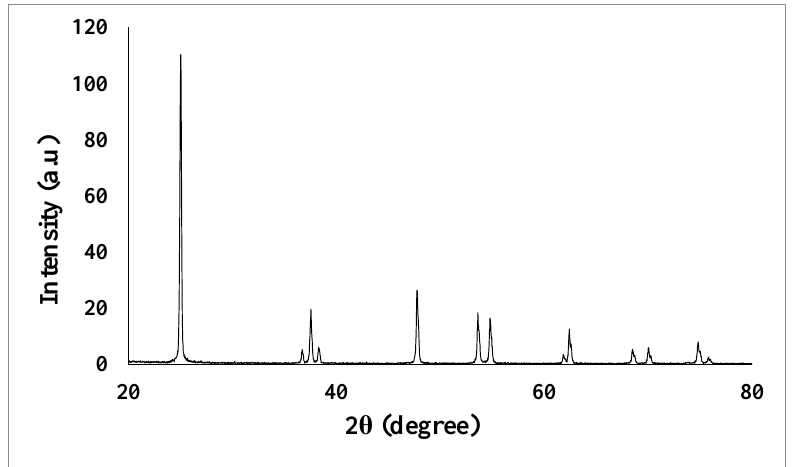
Figure 5. X-ray diffraction (XRD) analysis. Energies 2021 , 14 , x FOR PEER REVIEW